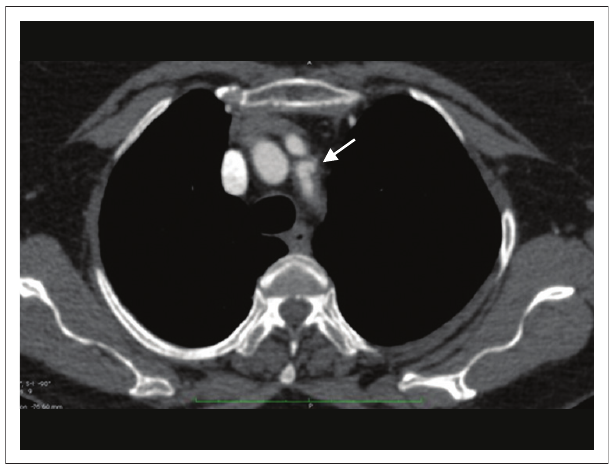
FIGURE 9: Penetrating atherosclerotic ulcer. Contrast-filled outpouching seen beyond the aortic wall involving the arch of the aorta (arrow).